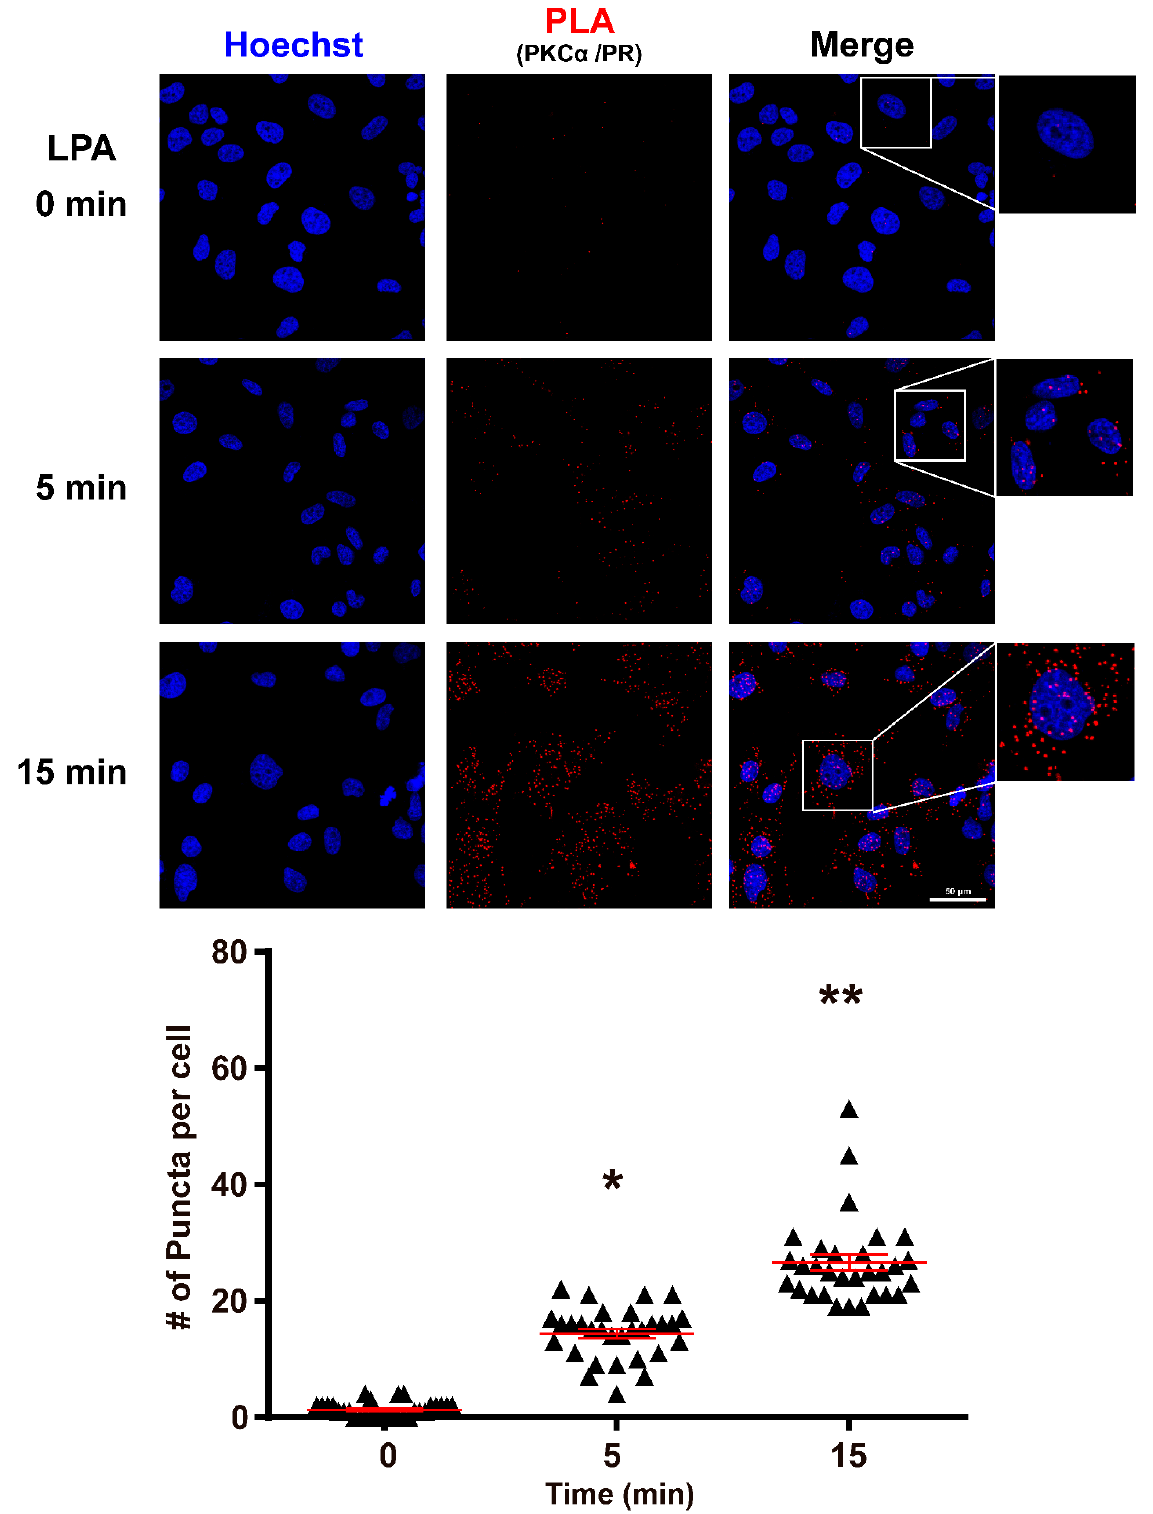
Figure 1. LPA induces the interaction of PKC α and PR. Top panel: representative images of the PLA assay. The red dots denote the proximity (distance less than 40 nm) of PKC α and PR at 0, 5 and 15 min of stimulation with 100 nM of LPA in the U251 cell line. Lower panel: graphic representation of the interactions. Results are expressed as the mean ± S.E.M. of 30 cells nuclei per condition. A one-way ANOVA statistical test followed by a Tukey’s post-test was used. * p < 0.001, compared to control (0) and 15 min, ** p < 0.001 compared to control (0).